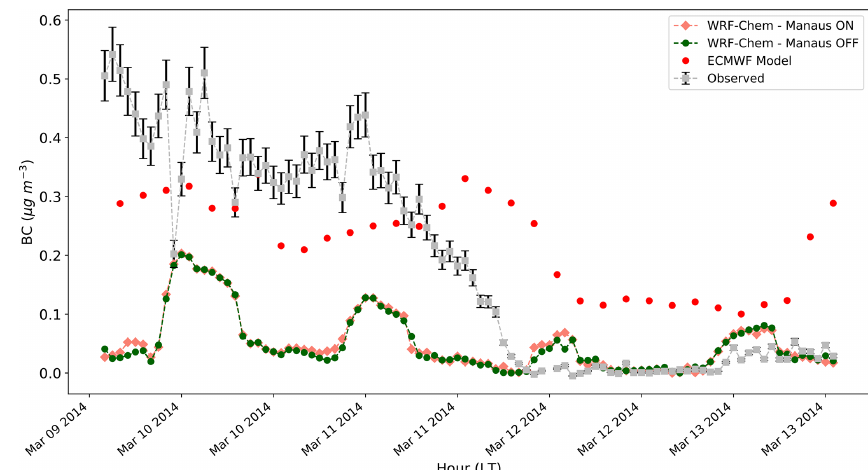
Figure 2. Observed and simulated surface black carbon (BC) concentration from 10 to 13 March 2014 at the T0a site. Standard deviation bars are shown for each set of measurements. Events due to long-range transport of Saharan dust and biomass burning emissions from West Africa are visible on 10 and 11 March (Moran-Zuloaga et al., 2018). The Manaus off (green) and Manaus on (orange) simulations show BC concentrations simulated at a height of ca. 8m above the surface. During BC transport event days, we can see that the simulation had the largest peaks as it tried to represent the BC transport coming from West Africa. The global model contribution (red dots) also represents BC transport event days, showing the largest values during 10 and 11 March.